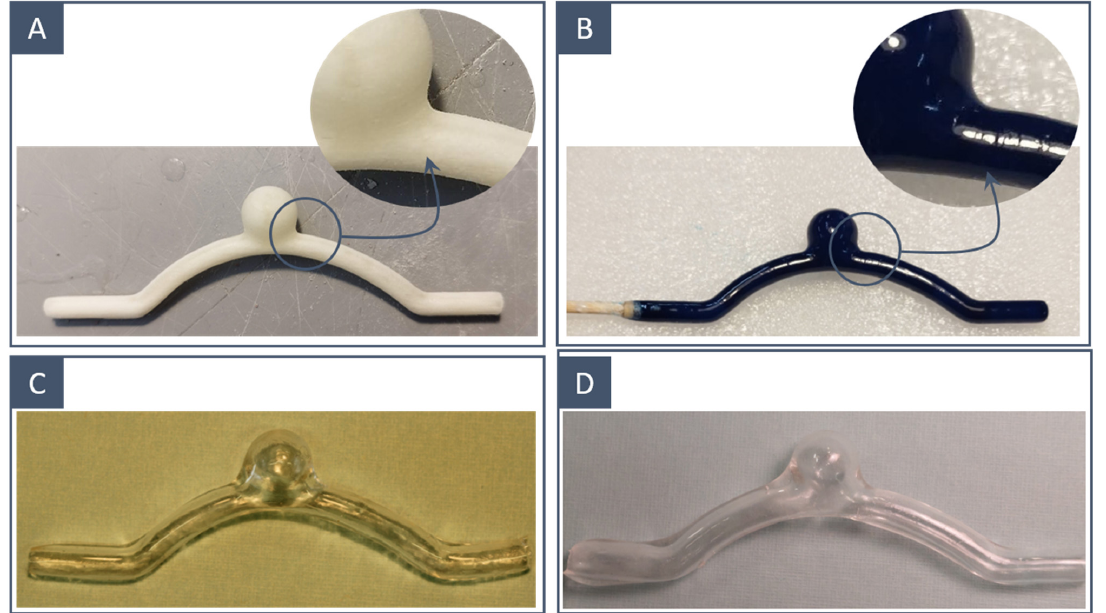
Figure 6. Comparison between 3D printing techniques to obtain water-soluble inner moulds: ( A ) FDM-printed inner mould and ( B ) SLA-printed inner mould; ( C ) final model corresponding to FDM-printed inner mould and ( D ) final model corresponding to SLA-printed inner mould.